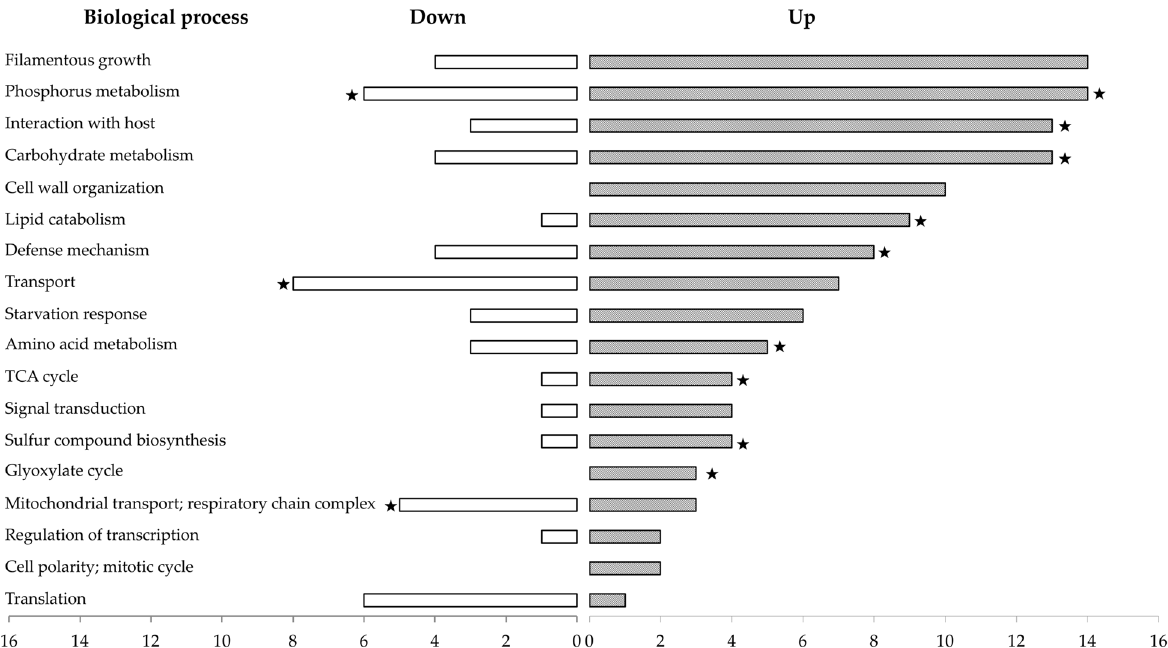
Figure 7. Functional distribution of the proteins found differentially expressed in the REC strain (carrying the med15 Δ mutation) compared with the WT (6936) strain. Proteins were classified in biological processes based on their predicted functions using gene ontology (GO) annotations from C. lusitaniae (ATCC42720) and C. albicans (SC5314) in Uniprot database. The number of proteins down-regulated or up-regulated can be read on the horizontal axis. Since proteins can be linked to more than one annotation group, the sum of annotated genes is larger than the number of total up- and down-regulated genes in the set analyzed. The categories found statistically enriched by DAVID tool (https://david.ncifcrf.gov, accessed on 21 February 2023) are marked with an asterisk ( p -value < 0.05). Because the analysis was performed using C. lusitaniae reference genome ATCC42720, enrichment of some biological processes annotated from C. albicans SC5314 could not be